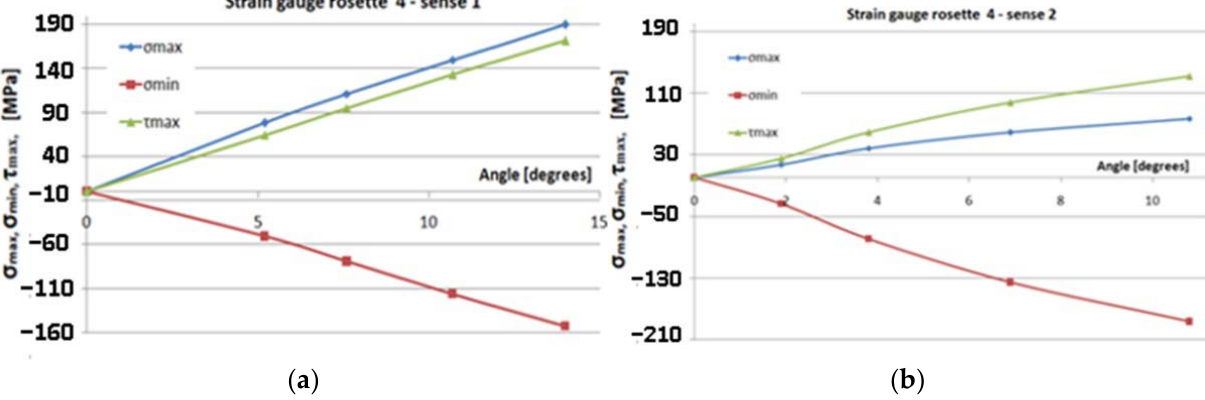
Figure 20. Gauge 4–sense 1,2: the variation of the maximum normal main stress σ max , σ min , and τ max , in relation to the angle of rotation. ( a ) Sense 1; ( b ) sense 2.